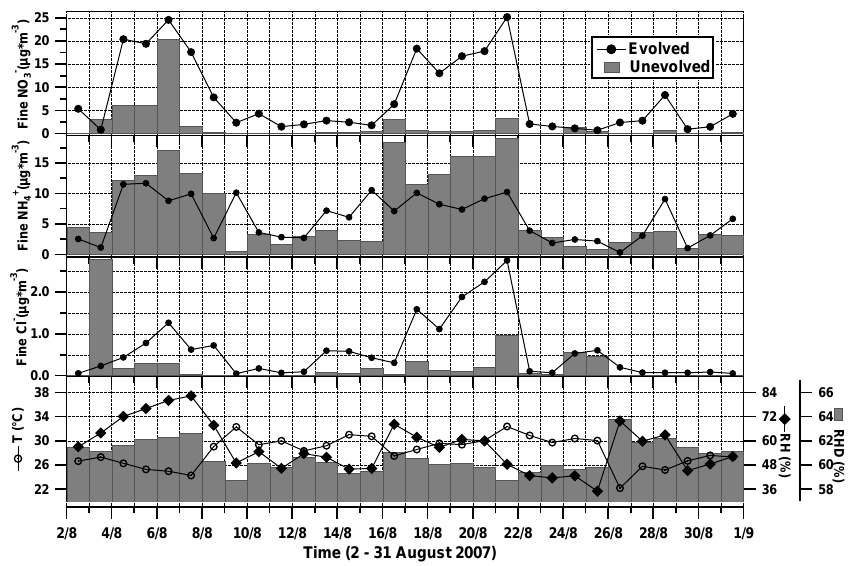
Fig. 4. Temporal trends of temperature ( T ) , relative humidity (RH), deliquescent relative humidity (RHD), and evolved and unevolved fine ) , sulphate (SO 2 − ) , nitrate (NO − ) and chloride (Cl − ) during the summer measurements, carried out on a 24-h particulate ammonium (NH + 4 4 3 basis, at